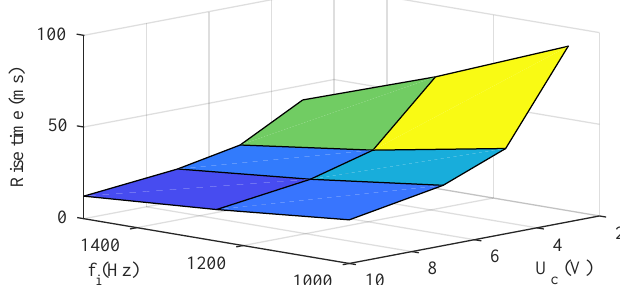
Figure 10. Response time measured for different amplitude and frequency